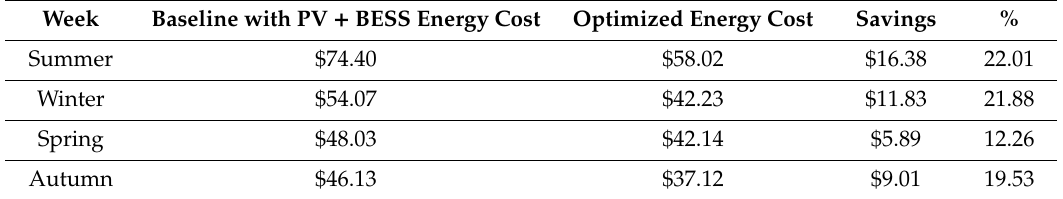
Table 5. Scenario 3 weekly savings.